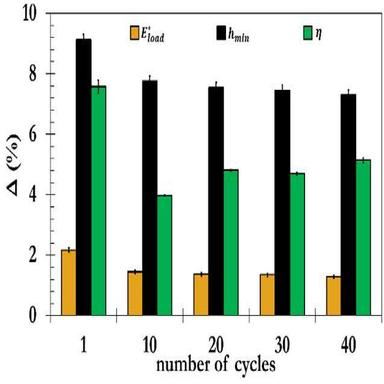
Histogram representing the percent difference between composite core and composite surface mean values of instantaneous elastic modulus (yellow), residual depth (black) and energy ratio (green) for 1st, 10th, 20th, 30th and 40th cycle.